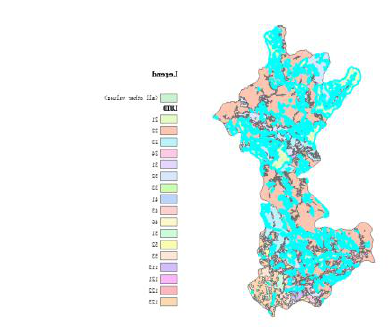
Figure2 ： Land-use and Land-cover of Huairou in 2006